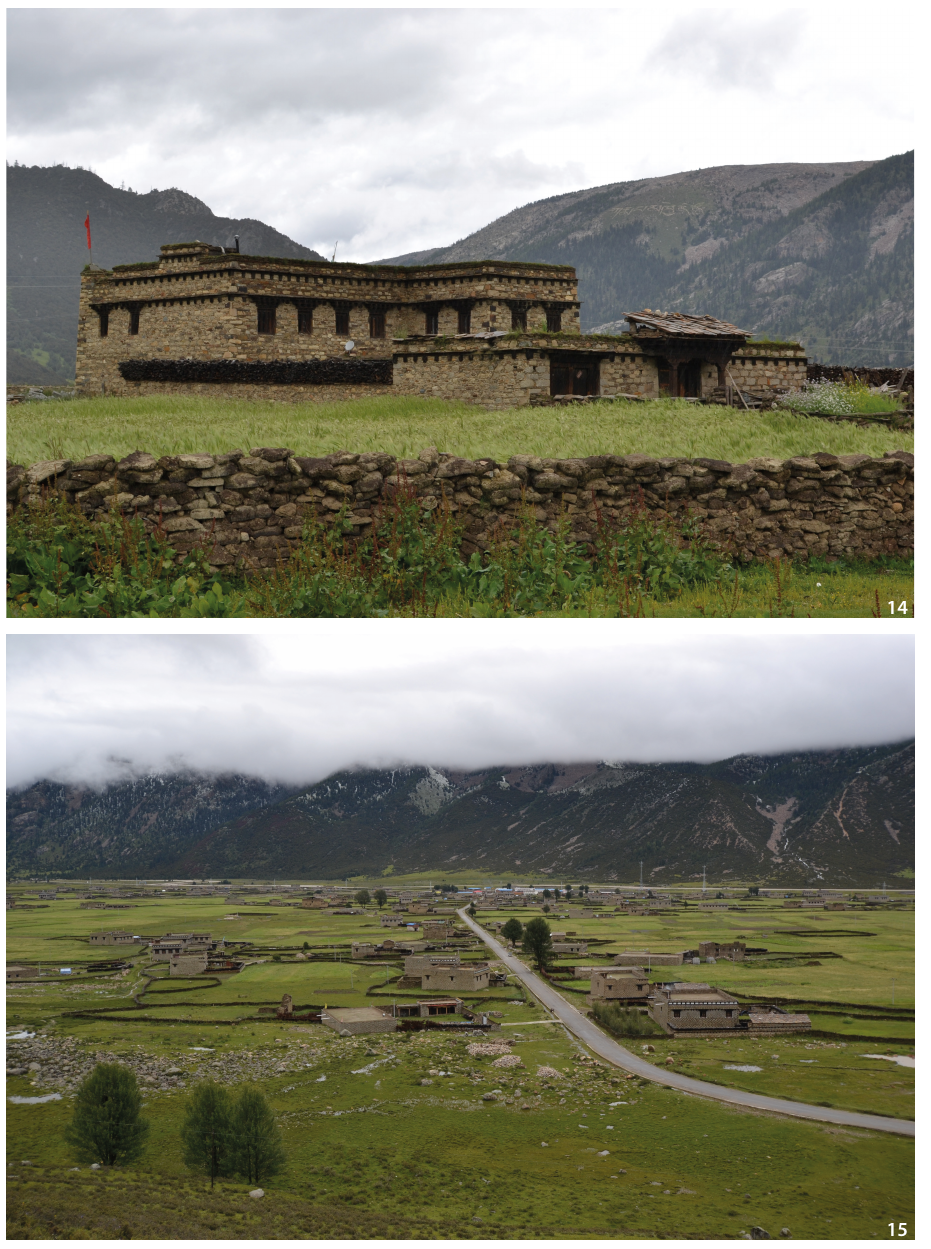
Figure 14 View of the farmhouse in Dabpa from the south (Source: the authors). Figure 15 Sumdu Village in the region of Dabpa (Source: the au-